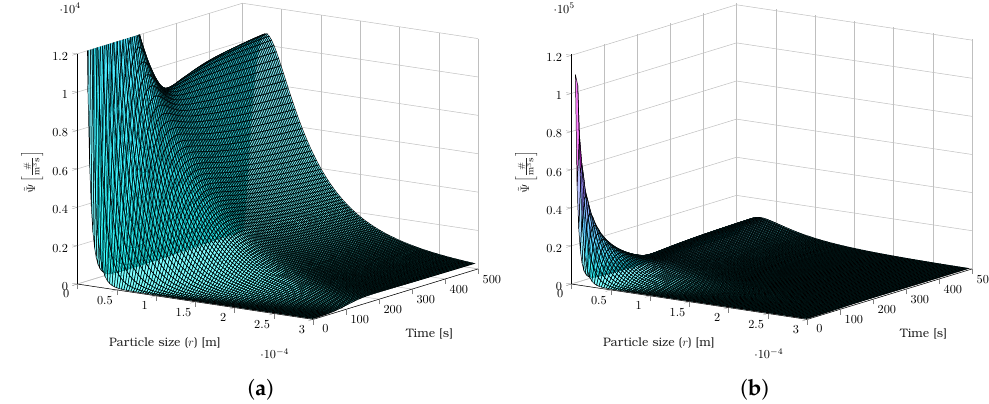
Figure 12. ( a ) Full scale; ( b ) zoomed scale of the particle distribution in the case of the isothermal batch